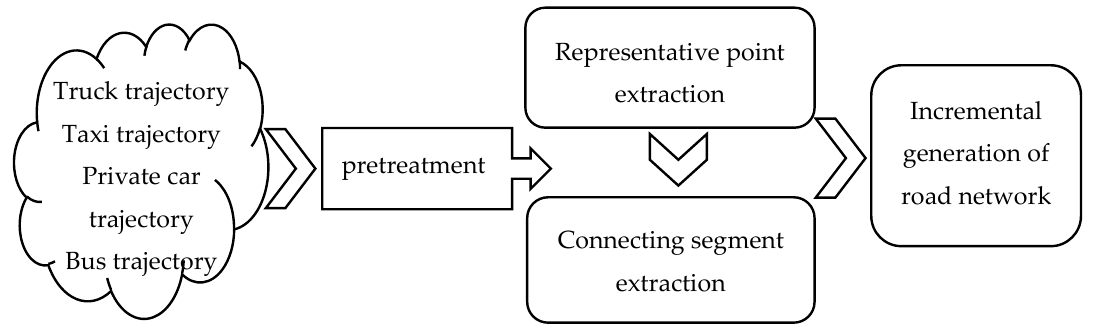
Figure 2. Road network extraction algorithm flow.